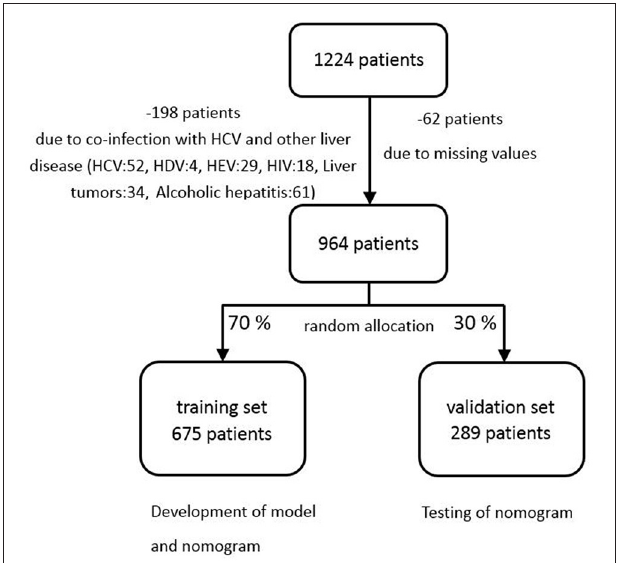
FIGURE 1 | Flow chart of subjects